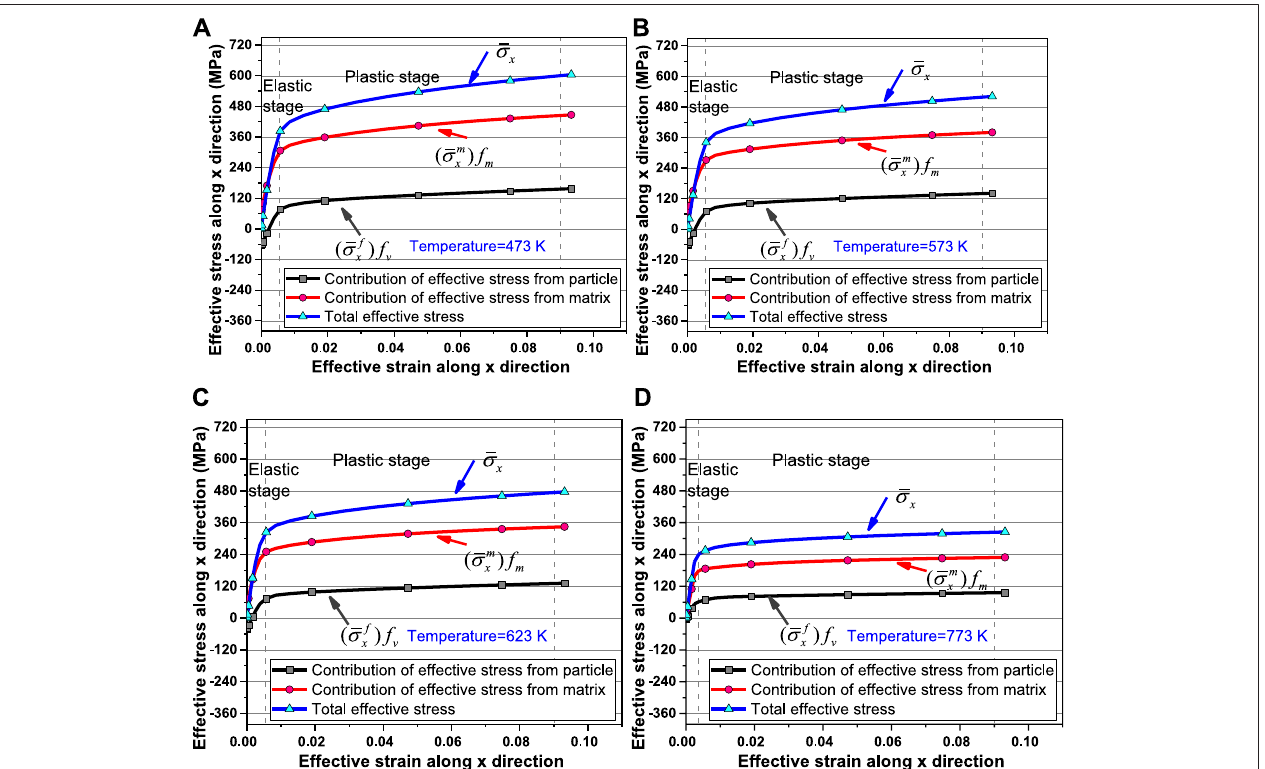
FIGURE 11 | Effective stress/strain curves and the effective stress contributions under the test temperature of (A) 473 K, (B) 573 K, (C) 623 K, and (D) 773 K.